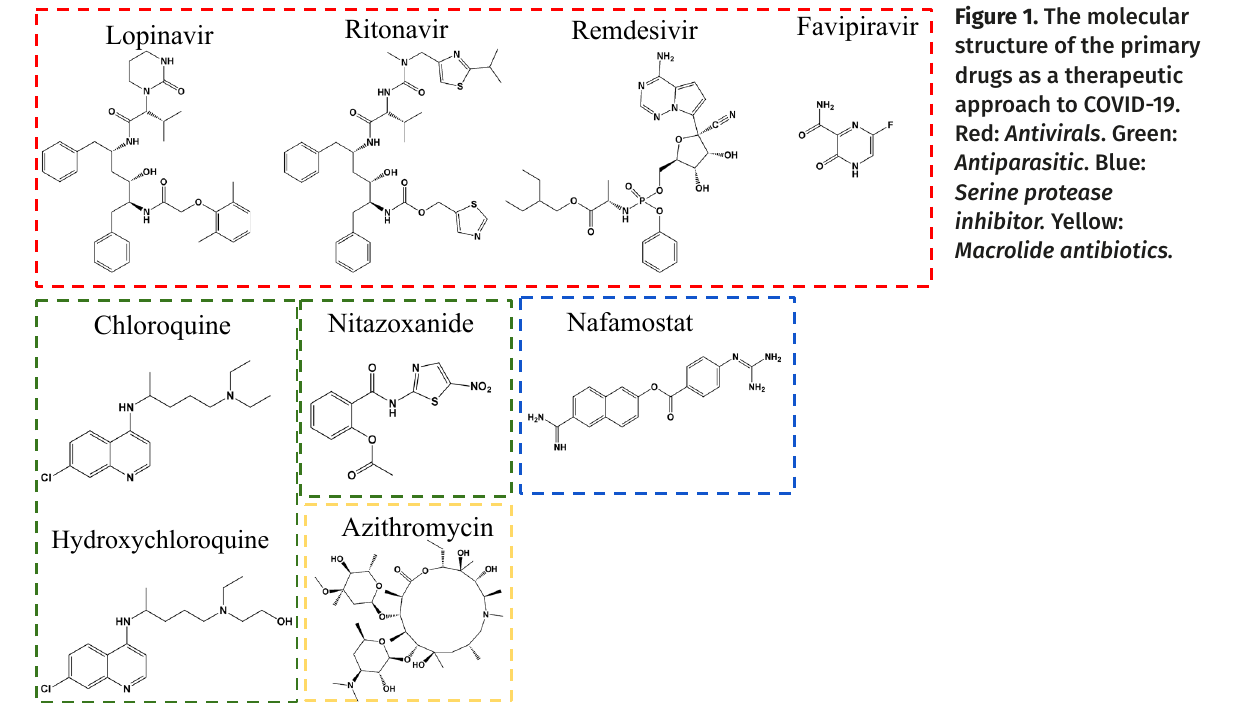
Figure 1. The molecular structure of the primary drugs as a therapeutic approach to COVID-19. Red: Antivirals . Green: Antiparasitic . Blue: Serine protease inhibitor. Yellow: Macrolide